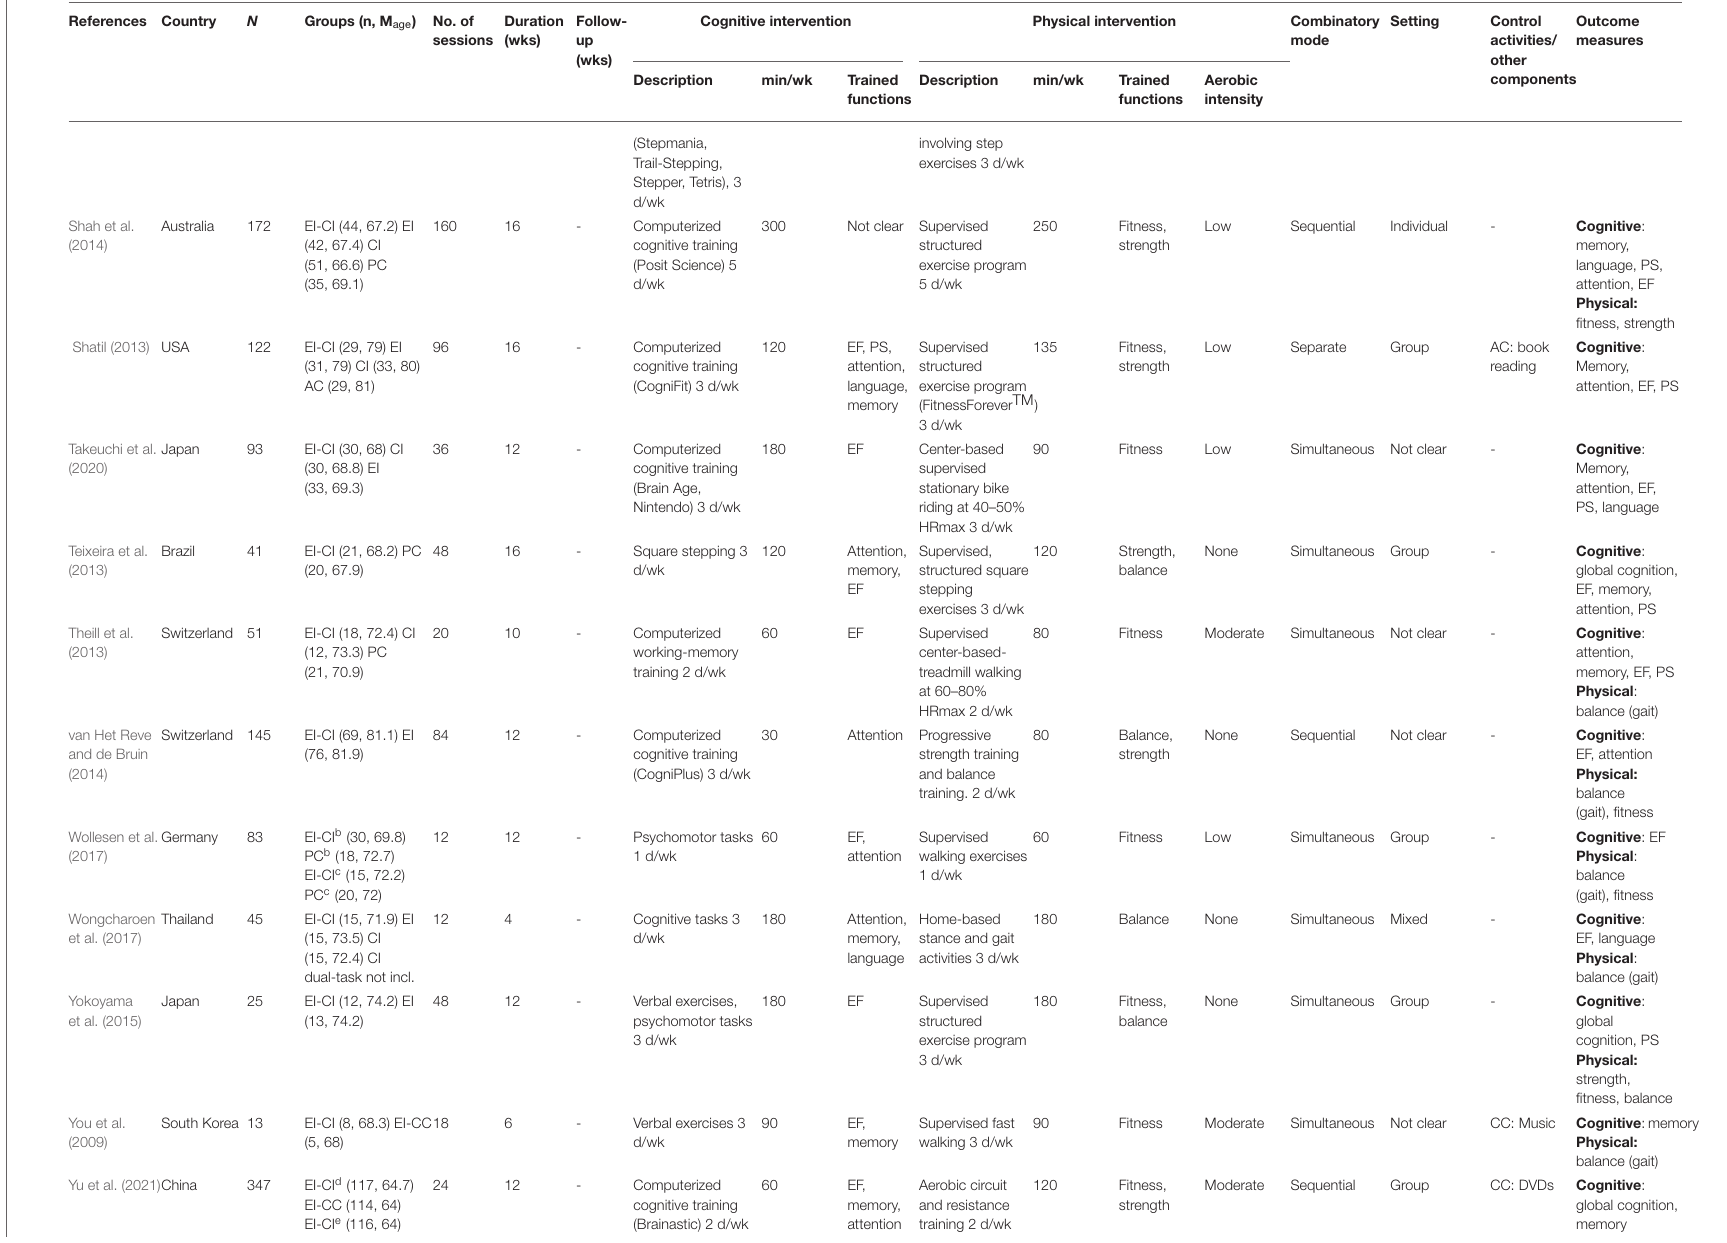
Yu et al. (2021)China - Computerized